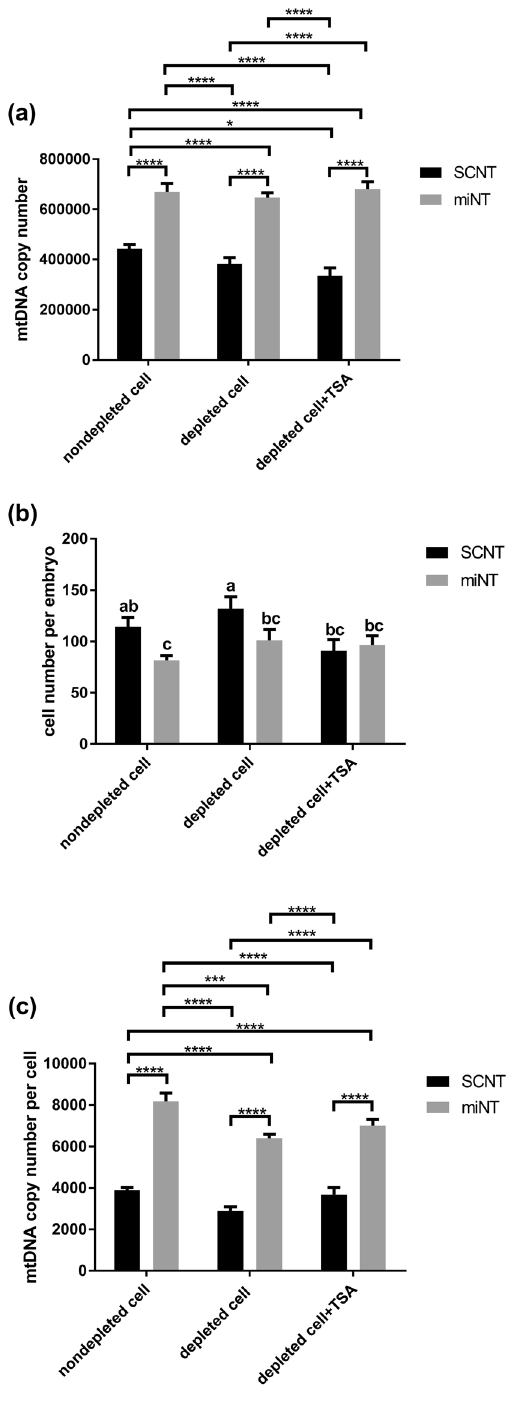
Figure 1. Assessment of cell number and mtDNA copy number in miNT- and SCNT-derived embryos at the blastocyst stage. ( a ) mtDNA copy number per embryo (n = 10/group). Mean values ( ± SEM) are shown. The differences were analysed for significance by two-way ANOVA with Sidak’s multiple comparisons test using GraphPad Prism version 6.01. * , **** indicate P < 0.05 and P < 0.0001, respectively. ( b ) Cell number for miNT and SCNT embryos at the blastocyst stage (n = 3/group). Mean values ( ± SEM) are shown. Different superscripts within a column indicate significant differences (P < 0.05, ANOVA with Duncan’s multiple range test). ( c ) mtDNA copy number per cell (n = 10/group). Mean values ( ± SEM) are shown. The differences were analysed for significance by two-way ANOVA with Sidak’s multiple comparisons test. *** , **** indicate P < 0.001 and P < 0.0001, respectively. SCNT-derived embryo data were obtained from our previous report 50 . The embryos were produced at the same time